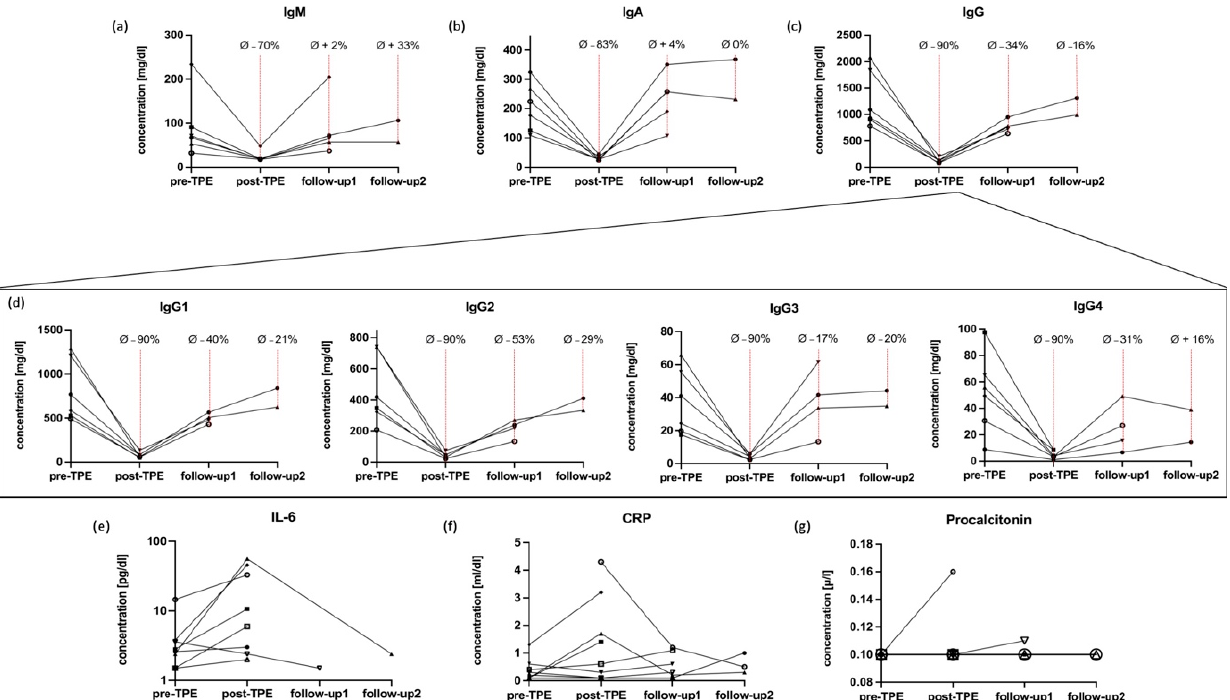
Figure 2. Absolute changes in humoral and soluble components of the immune system associated with TPE. All immunoglobulin subclasses were substantially removed by TPE ( a – d ). IgA and IgM, however, recovered faster than IgG. The IgG subclasses 1–3 did not reach baseline values throughout the follow-up, while IgG4 levels fully recovered at follow-up2 ( d ). As for changes in soluble factors, IL-6 and CRP were observed to be increased in response to TPE ( e , f ) while procalcitonin was not affected ( g ). Follow-up1 and follow-up2 were conducted 5 weeks and 130 days after the last TPE session, respectively. Data from individuals treated with immunosuppressive drugs (anti-CD20 monoclonal antibodies n = 2; azathioprine n = 1) and/or with intravenous immunoglobulins (IVIG; n = 5) after TPE were excluded from the respective follow-ups ( a – e ). One patient was lost to follow-up after TPE. Symbols and connecting lines show the raw data of each patient included at the respective time of sampling. Pre-TPE = prior to therapeutic plasma exchange; post-TPE = immediately after therapeutic plasma exchange; Ø = average change to baseline levels; IL-6 = interleukin 6; CRP = C-reactive protein.